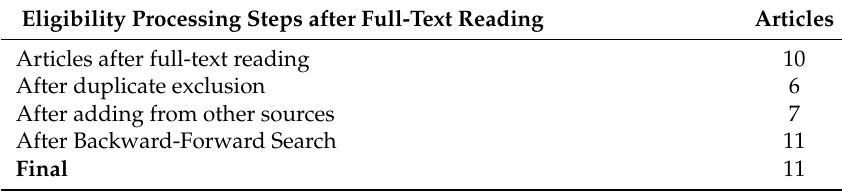
Table 7. Eligibility processing steps after full-text